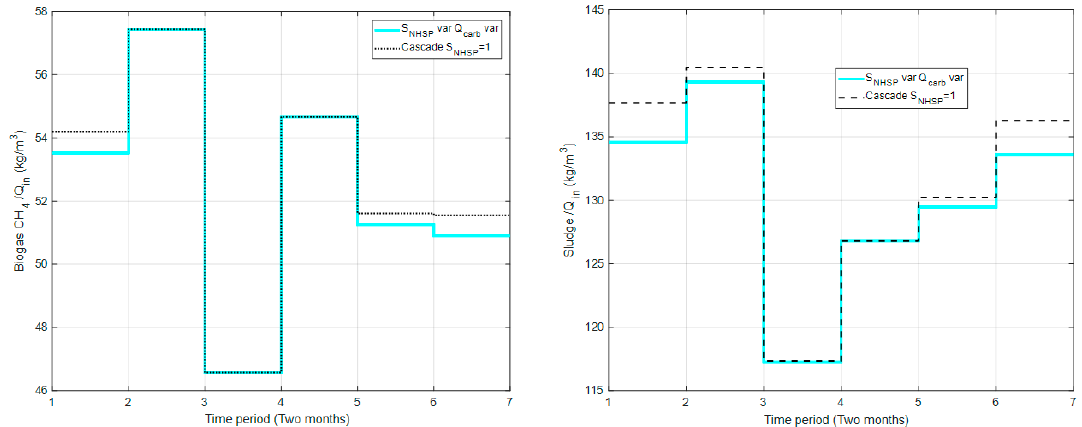
Figure 12. Bimonthly profile for biogas (kg/m 3 ) and sludge production (kg/m 3 ) indicators with Cascade S NHSP and the alternative strategy.